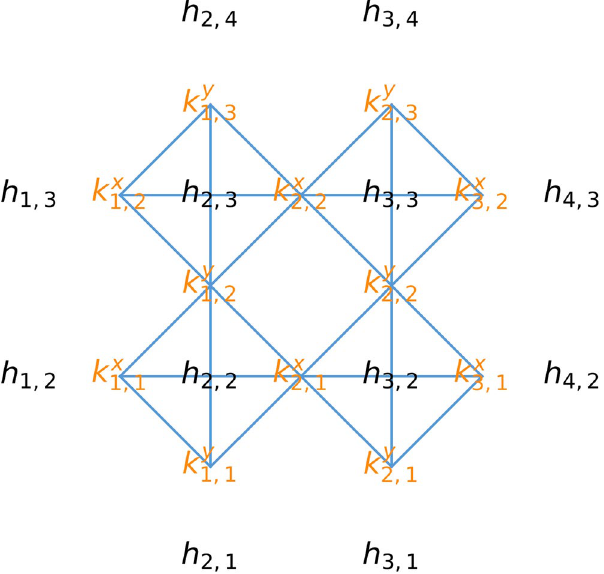
Figure 1. A small-scale 2D finite difference grid is shown with the heads (black), permeabilities (orange), and the couplings between the permeabilities (blue